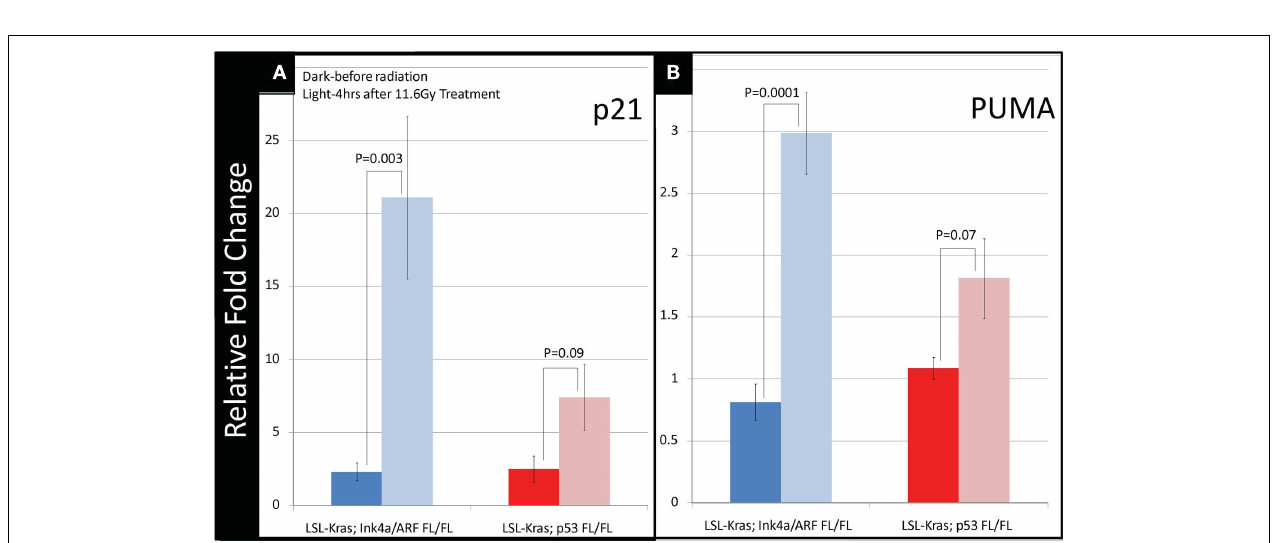
FIGURE 3 | Quantification of relative tumor volume 14days after a single 11.6Gy fraction or two 7.3Gy fraction radiation treatments. Lung cancers in (A) LSL-Kras; Ink4a/ARF FL/FL and (B) LSL-Kras; p53 FL/FL mice were imaged prior to radiation therapy (Day 0) and 2weeks after radiation therapy (Day 14). Graphs show the average fold change for the lung tumors at 14days. (A) Lung cancers in LSL-Kras; Ink4a/ARF FL/FL mice show improved response to two